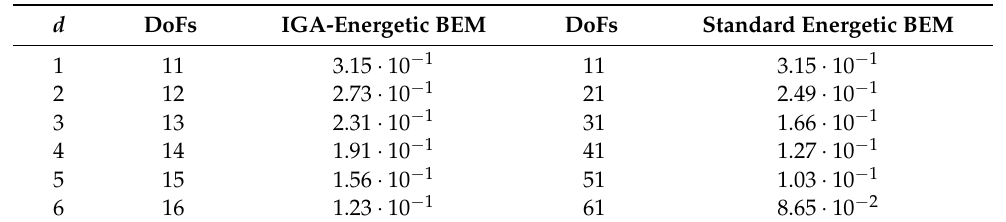
) ψ ∞ ( / (cid:107) · (cid:107) H − 1 2 ( Γ )